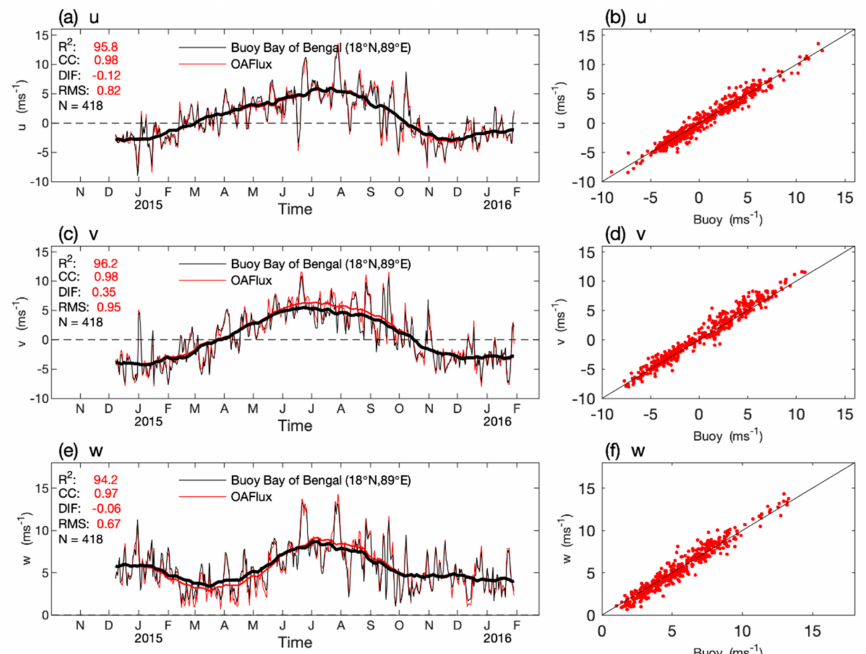
Figure 5. Left column: time series plots of daily buoy winds (thin black) versus OAFlux-HR winds (thin red). Right column: scatter plots of collocated pairs at the Bay of Bengal buoy location 18 ◦ N, 89 ◦ E. ( a , b ) zonal wind component, ( c , d ) meridional wind component, ( e , f ) wind speed. Thick smoother lines in ( a , c , e ) denote a 21-day running mean with black for buoy and red for